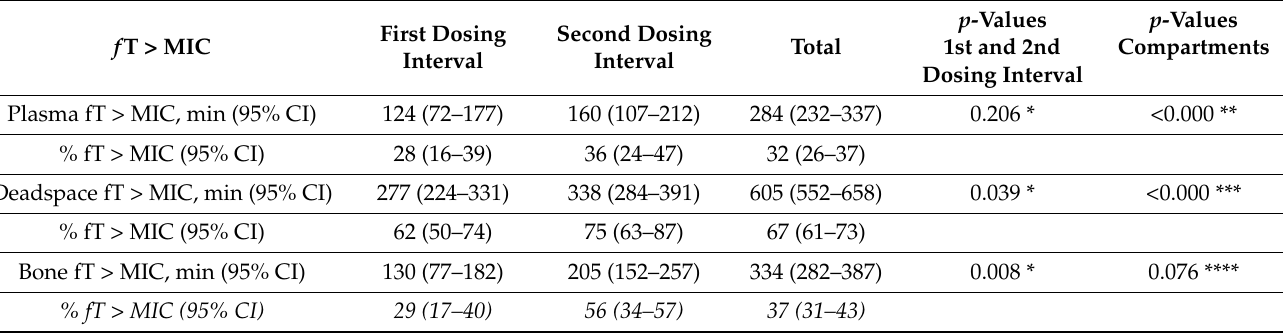
Table 2. A pooled comparison across weight groups of mean f T > MIC for the two dosing intervals for plasma, deadspace and bone.